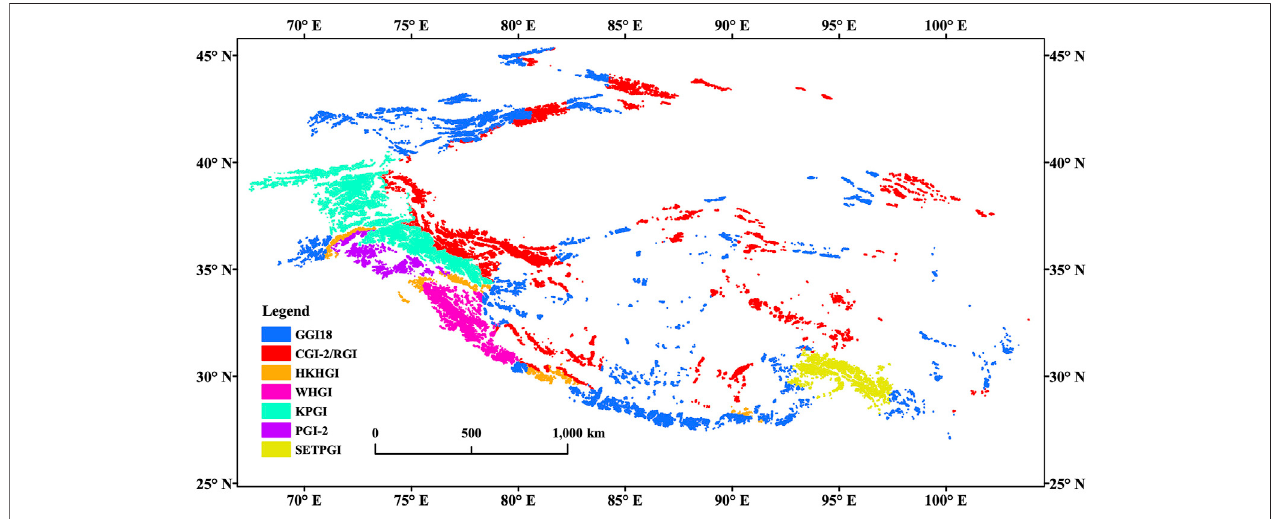
FIGURE 6 | A merged glacier inventory product of the best comprehensive quality data from the eight glacier inventories. See text for details.